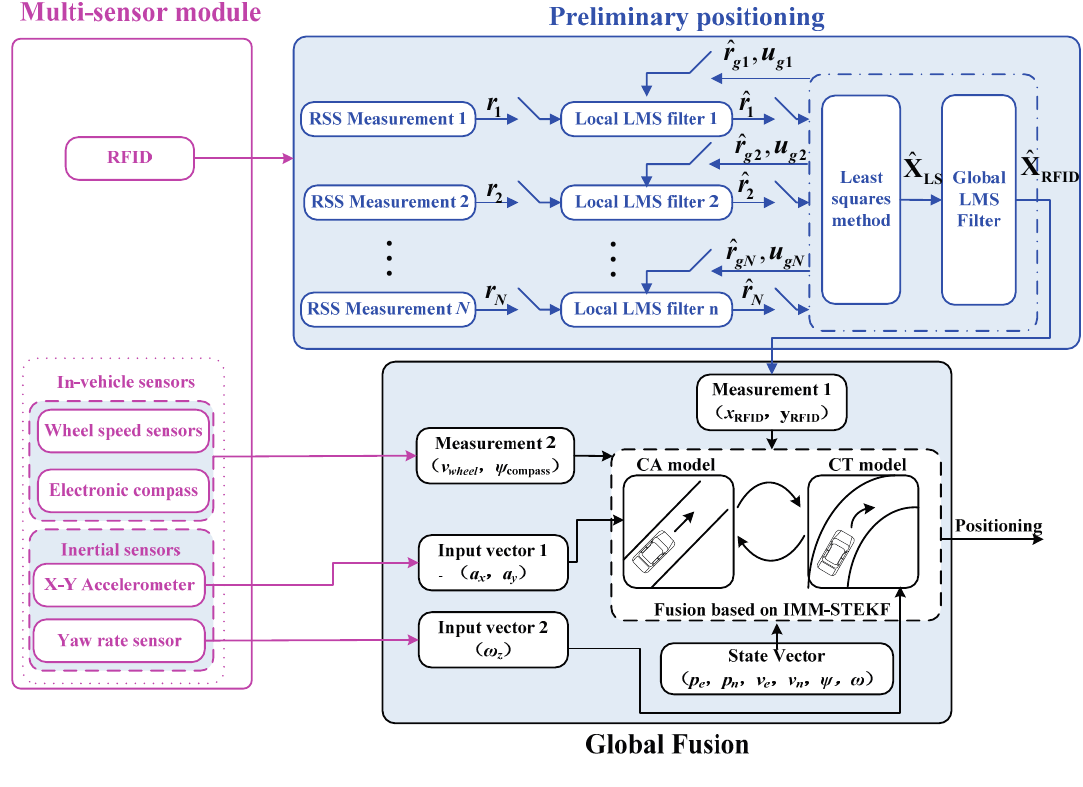
Figure 1. Proposed multi-sensor fusion strategy for vehicle positioning in a